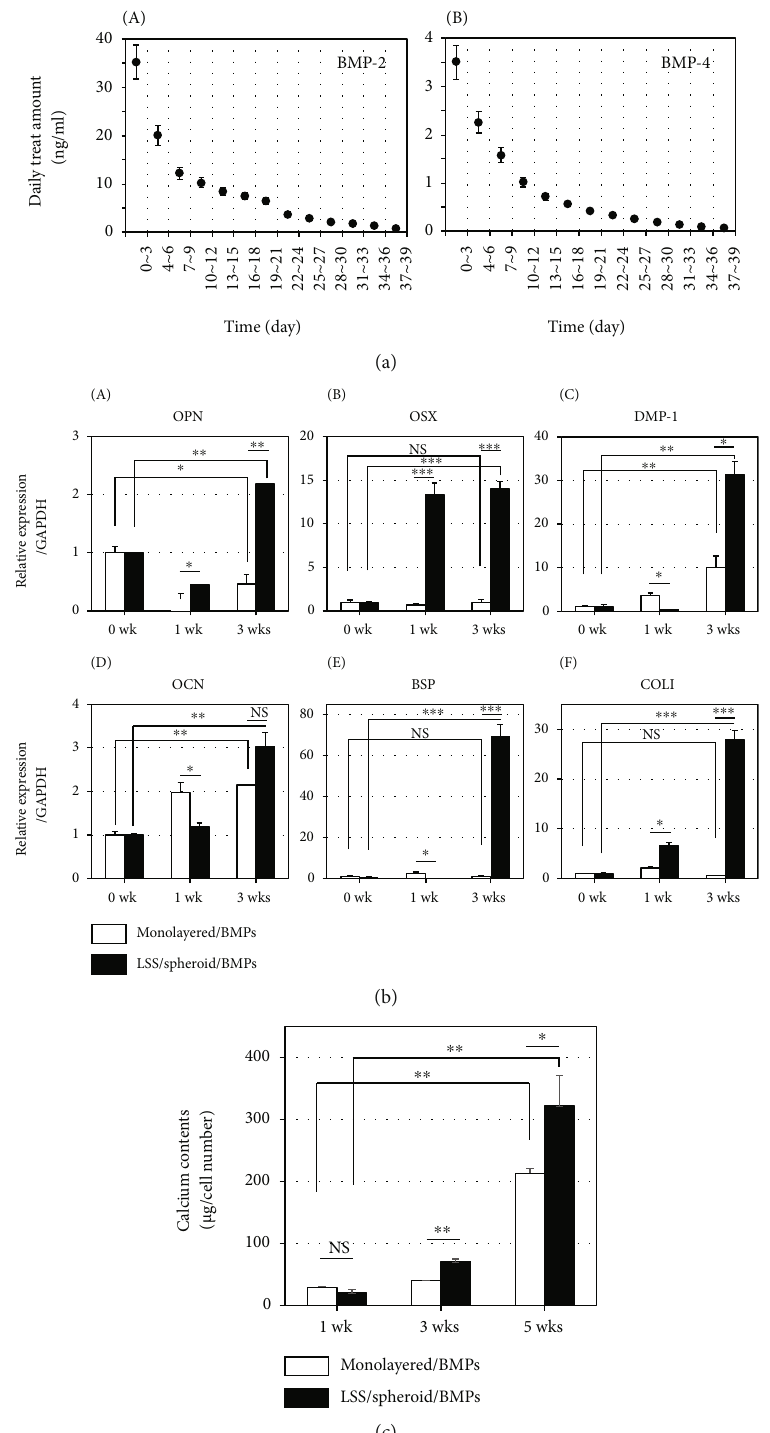
Figure 4: Comparison of odonto/osteoblastic di ff erentiation of 2D monolayer-cultured hDPSCs and 3D spheroid-cultured hDPSCs. (a) Daily treat amounts of BMP-2 (A) and BMP-4 (B) in 2D monolayered culture. hDPSCs on culture dish were treated with BMPs once every 3 days. Based on the release behavior from LSS particles (Figure 1(b)), the daily average value was calculated from the sum of three days ’ values and displayed on the graph as a point. (b) Odonto/osteoblastic marker gene expression in hDPSCs cultured in 2D monolayer and in 3D spheroids. (A) Osteopontin. (B) Osterix. (C) Dentin matrix protein-1. (D) Osteocalcin. (E) Bone sialoprotein. (F) Collagen type-1. ∗ P < 0 : 05 ; ∗∗ P < 0 : 01 ; ∗∗∗ P < 0 : 001 ; NS: not signi fi cant. (c) Calcium deposition in hDPSCs cultured in 2D monolayer and in 3D spheroids. 30 spheroids were collected to analyze the amounts of calcium as followed in Experimental procedures. White bars, 2D monolayer culture treated with BMPs; black bars, 3D spheroids containing particles loaded BMPs. ∗ P < 0 : 05 ; ∗∗ P < 0 : 01 ; NS: not signi fi